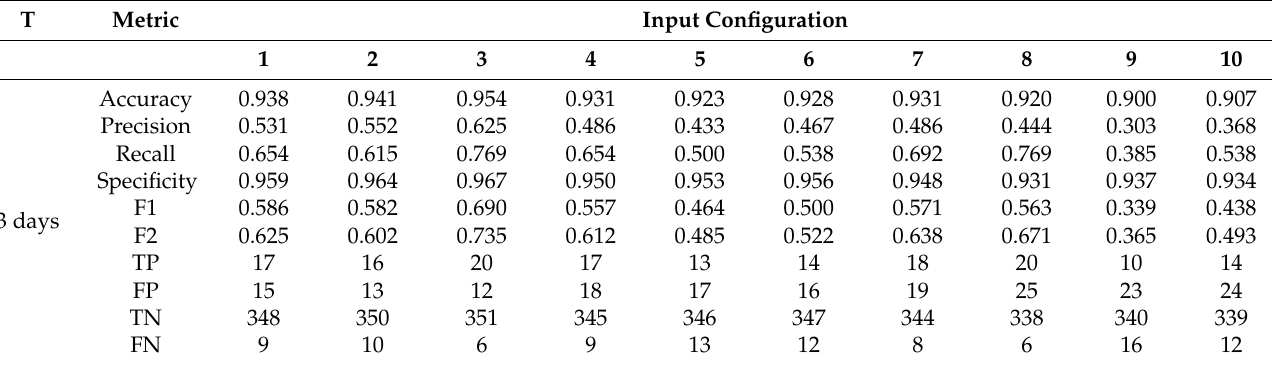
Table 5. RF model classification performance metrics with the MWMOTE-balanced